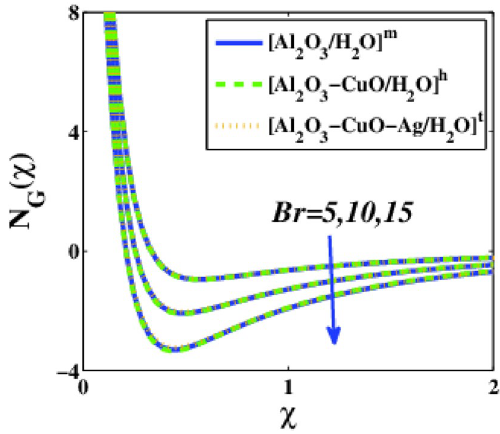
Figure 7. Impression of Br on N G (χ) .